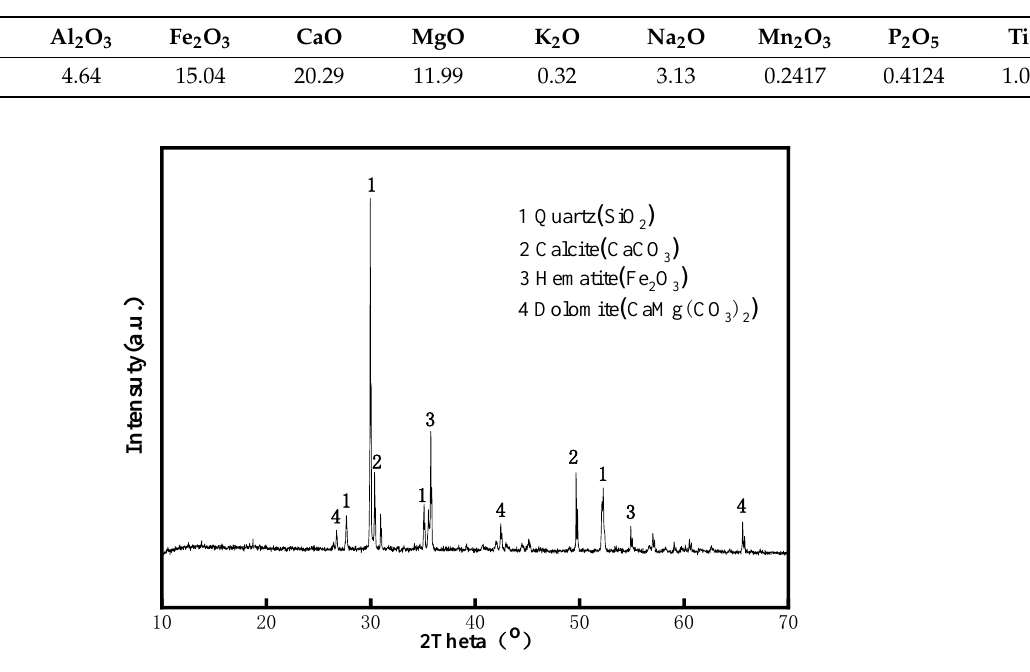
Table 3. Chemical composition of iron tailings (IT).